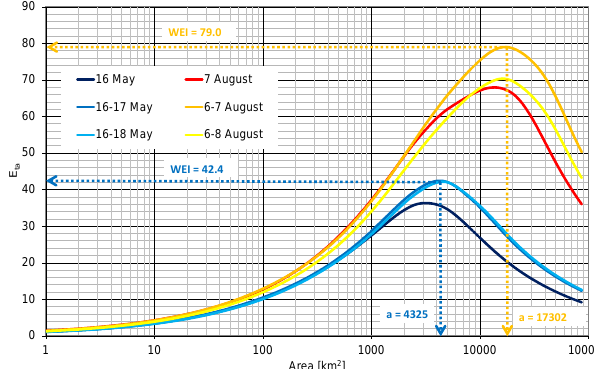
Fig. 6. Changes in E ta values with the increasing extent of the con- sidered area. The values of the WEI and the respective areas are depicted by